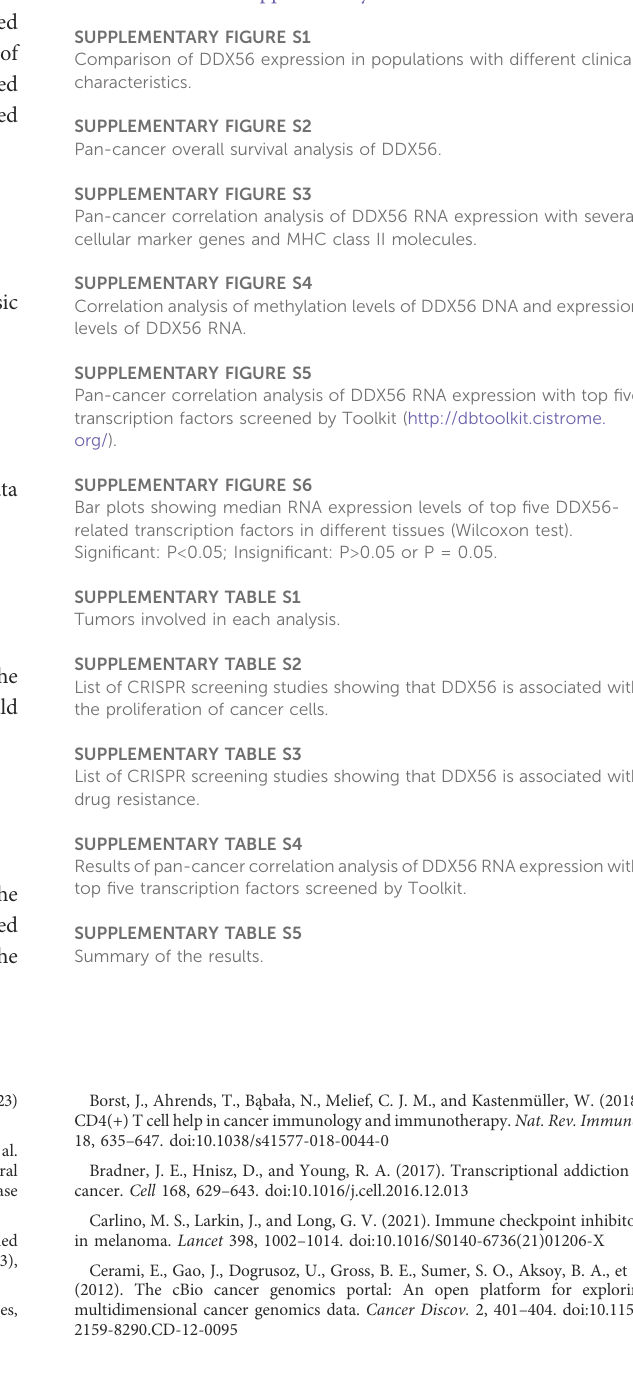
Pan-cancer overall survival analysis of DDX56. SUPPLEMENTARY FIGURE S3 Pan-cancer correlation analysis of DDX56 RNA expression with several cellular marker genes and MHC class II molecules. SUPPLEMENTARY FIGURE S4 Correlation analysis of methylation levels of DDX56 DNA and expression levels of DDX56 RNA. SUPPLEMENTARY FIGURE S5